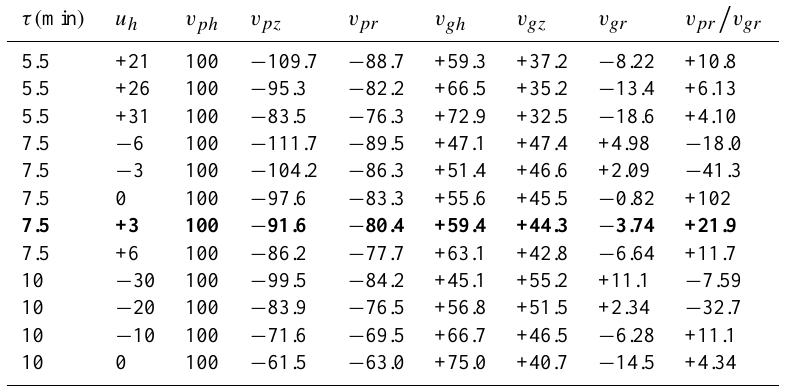
Table 1. Charateristic propagation velocities of gravity waves calculated from the dispersion relation with τ b = 5 . 0min, H = 8.0km, v ph = 100m/s and downward vertical phase propagation. The radar beam direction is defined by θ = 50 ◦ and φ = 225 ◦ . All the velocities are in m/s, wave periods in min. The case in the 7th row corresponds to the numerical wave packet of Fig. 1. τ( min ) u h v ph v pz v pr v